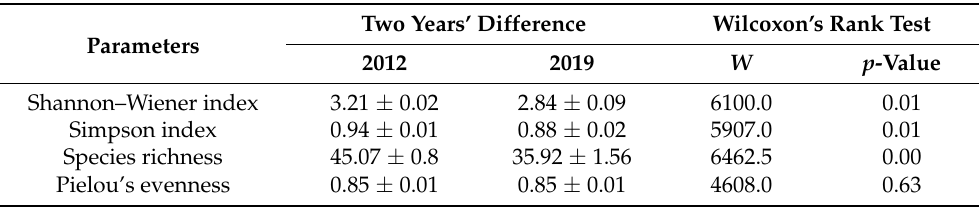
Table 1. Comparison of species richness, Shannon–Wiener Index, species evenness, and Simpson index between the two years (2012 and 2019). Values are mean ± standard deviation, N =